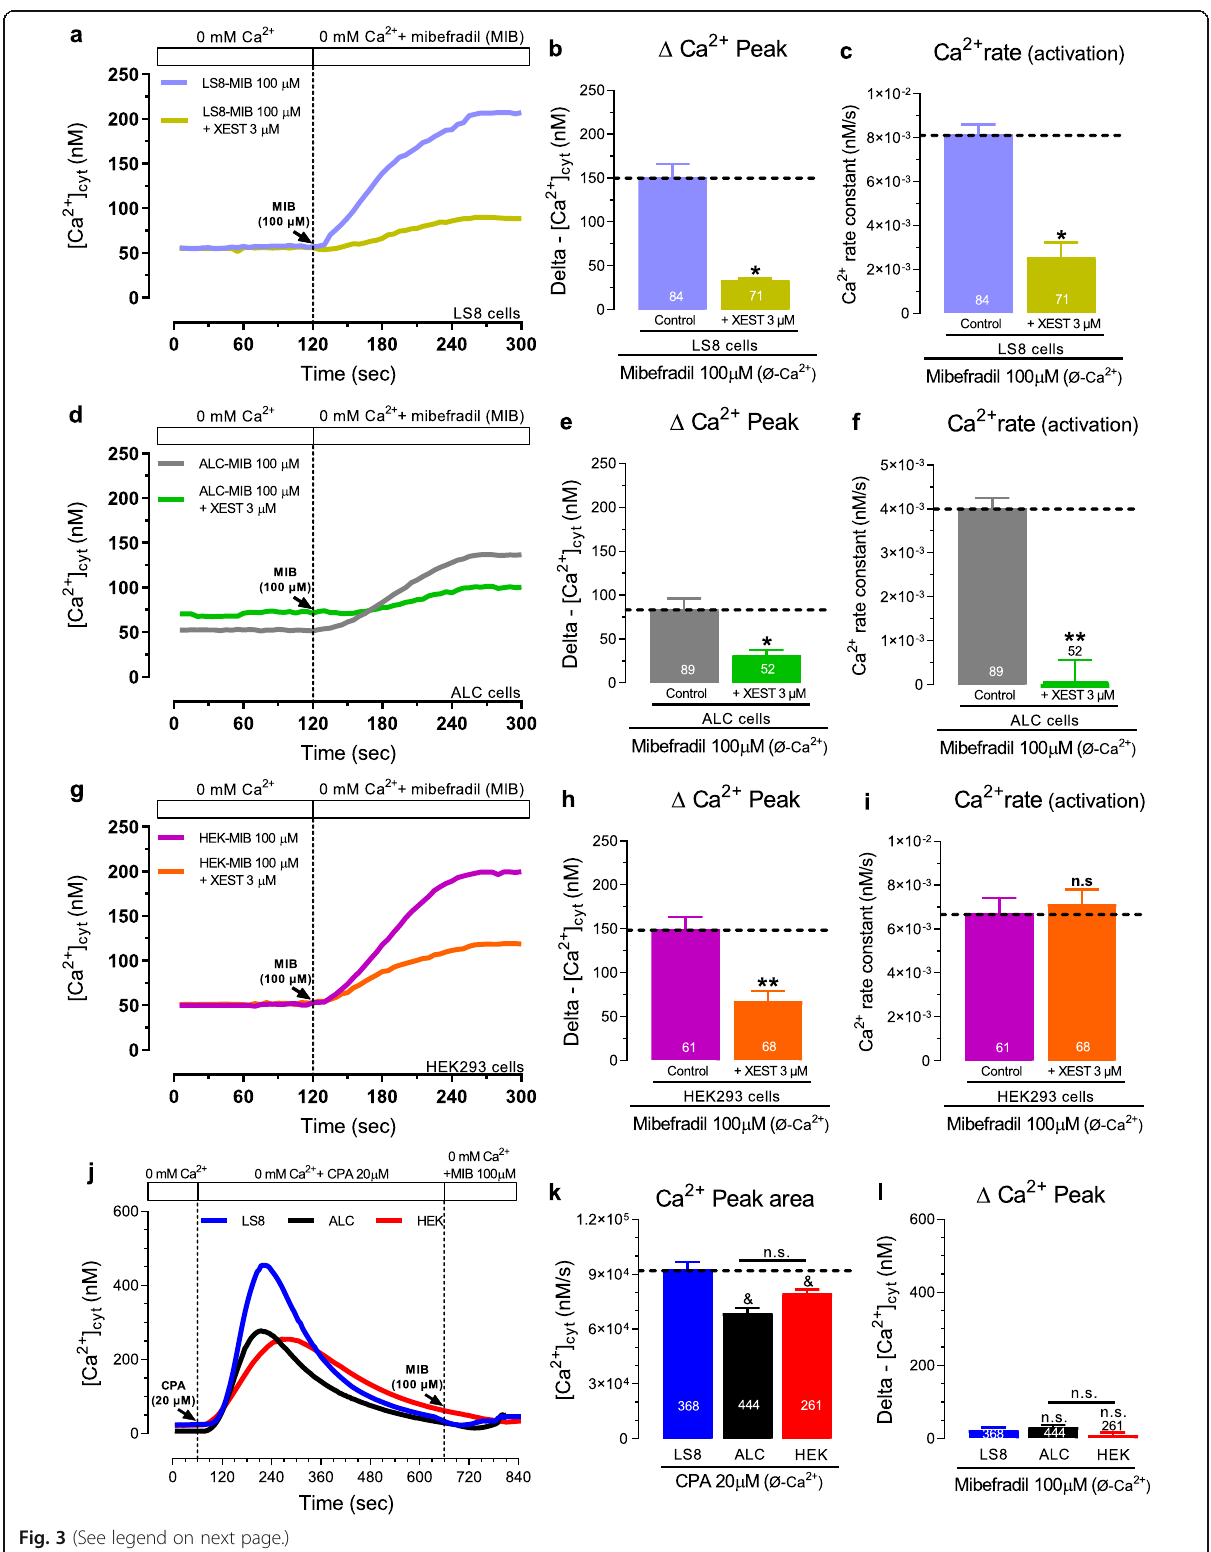
Fig. 3 (See legend on next